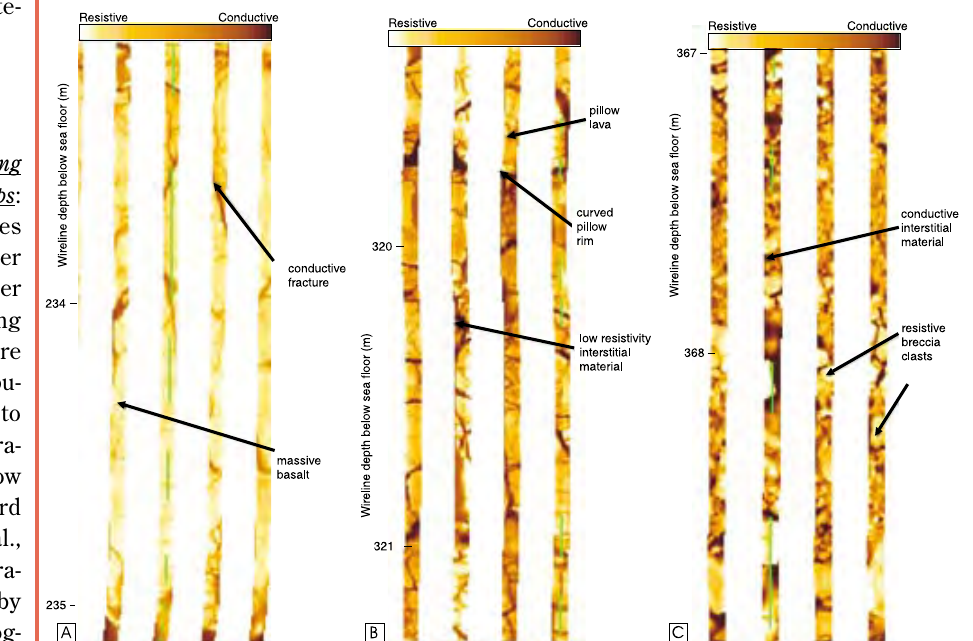
Figure 2. Formation MicroScanner (FMS) electrical images from ODP Hole 896A. [A] massive flow, [B] pillow lava, and [C] brecciated